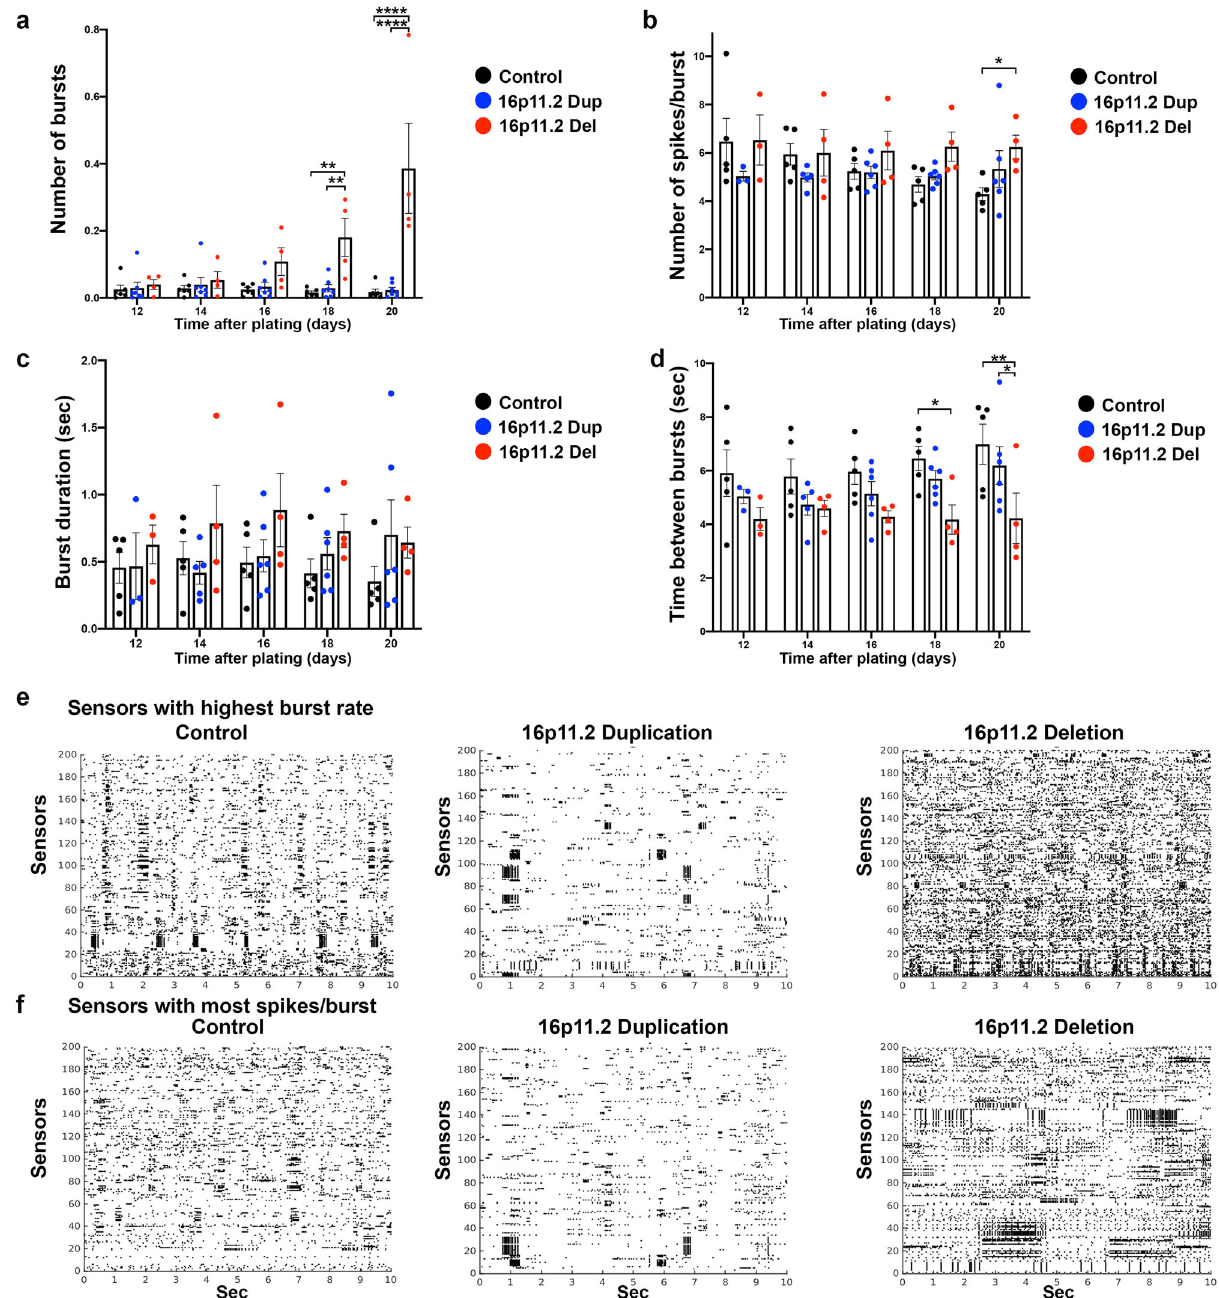
Fig. 6 DA neuron networks with 16p11.2 deletion have increased bursting phenotypes. a Quanti fi cation of the numbers of bursts/min over all sensors. 16pdel neurons have higher number of bursts compared to control or 16pdup neurons, adjusted p values for control vs. 16pdel: p = 0.0016 d18, p < 0.0001 d20 and for 16pdel vs.16pdup: p = 0.0029 d18, p < 0.0001 d20. b Quanti fi cation of the number of spikes/burst. Increased spike number/burst was detected in the 16pdel neurons compared to control neurons after 20 days of plating on HD-MEA, adjusted p values for control vs. 16pdel: p = 0.031 d20. c Quanti fi cation of the burst duration (s). No signi fi cant differences were detected in the burst durations between control, 16pdup, or 16pdel neurons. d Quanti fi cation of the time between bursts (s). Shorter time between bursts were detected in the 16pdel neurons compared to control or 16pdup neurons, adjusted p values for control vs. 16pdel: p = 0.0237 d18, p = 0.0049 d20, and for 16pdel vs. 16pdup: p = 0.0471 d20. e Representative raster plots of 200 selected sensors with highest burst rate/chip from the control, 16pdup, and 16pdel groups. f Representative raster plots of 200 selected sensors with most spikes per burst/chip from the control, 16pdup, and 16pdel groups. Datasets were calculated by making interpolation of each data point recorded per chip per day, and averaged data from each group of chips together based on their genotype: control ( n = 6), 16pdup ( n = 7), and 16pdel ( n = 4). Data are presented as mean ± SEM ( a – d ). Two-way ANOVA followed by Tukey ’ s multiple comparisons test, and adjusted p values, presented p value * p < 0.05, ** p < 0.01, and **** p < 0.0001. Source data are provided as a Source Data fi